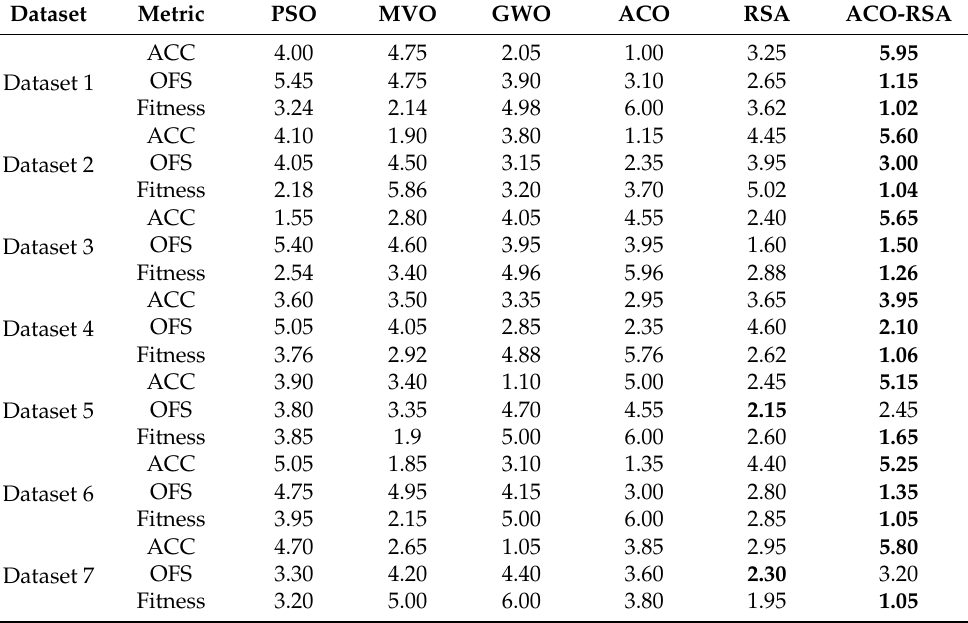
Table 7. Friedman ranking results for the ACO-RSA and the other MAs across all metrics. Dataset